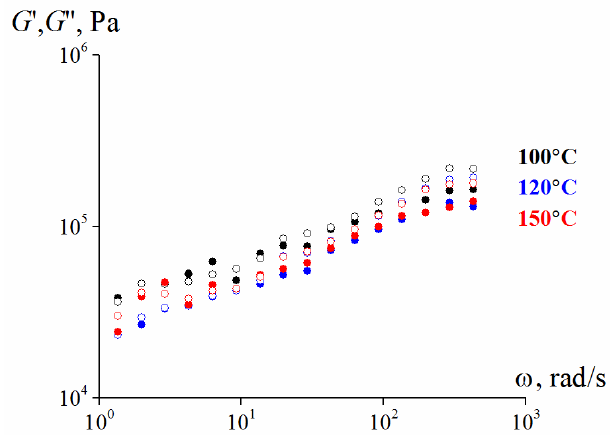
Figure 13. Frequency dependences of the components of dynamic modulus (amplitude 0.001) at different temperatures (the storage modulus is marked by dark symbols, the loss modulus—by light ones).